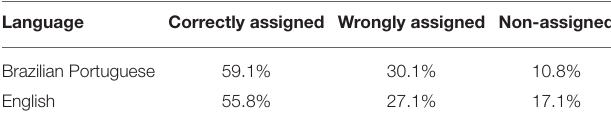
TABLE 1 | Evaluation of Daisy, using the FE-F relation in Brazilian Portuguese and English for the assignment of frames to lemmas.